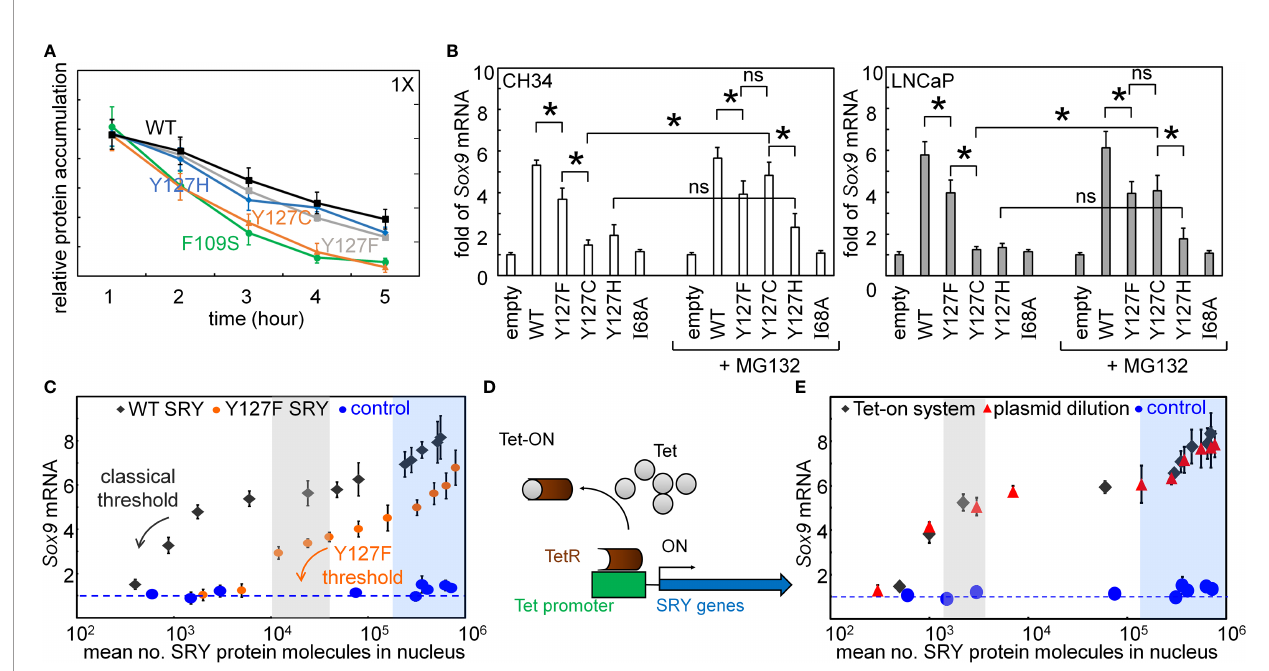
FIGURE 5 | Assays of transcriptional activity. (A) Cycloheximide assay. Whereas Y127F and Y127H did not affect degradation (relative to WT), proteolysis was accelerated by Y127C [to an extent similar to that induced by clinical variant F109S (31)]. (B) Effects of chemical proteasome inhibition on gene-regulatory activities in rodent cell line CH34 [(48); left] and human cell line LNCaP [(62, 63); right]: fold-change in Sox9 / SOX9 gene expression in absence (left) or presence (right) of MG132. The latter alters activity of Y127C SRY, but not Y127F or Y127H SRY. Statistical analyses: “ ns ” indicates no signi fi cant difference, asterisks indicate p<0.05. (C) Relationship between WT SRY or Y127F SRY expression at the protein level (absolute units; molecules/cell) and fold-gene activation: ( ) WT human SRY, ( ) inherited variant Y127F SRY, and ( ) inactive I68A SRY control. Levels of WT, Y127F, and I68A SRY were controlled by the Tet-on system as in (C) Arrows indicate respective WT and Y127F thresholds protein concentrations (black and orange, respectively). (D) Schematic mechanisms of Tet-on system (70), which enables tuning of SRY expression in physiological range [10 3 -10 4 protein molecules/cell (30)]. (E) Relationship between SRY/Sry expression at the protein level (absolute units; molecules/cell) and fold-gene activation: ( ) SRY expression regulated by Tet-on system, ( ) SRY expression controlled by encoded plasmids dilutions, and ( ) I68A SRY as inactive control. Shaded areas indicate TF thresholds (blue or gray), below which Sox9 mRNA abundance is attenuated and above which such expression is robust to changes in SRY/Sry concentration. Blue-shaded region also indicates marked TF over-expression. Shading and color code are as in C WT ( Figure 6C , black traces). Speci fi c DNA af fi nities and DNA bend angles are thus uncorrelated.